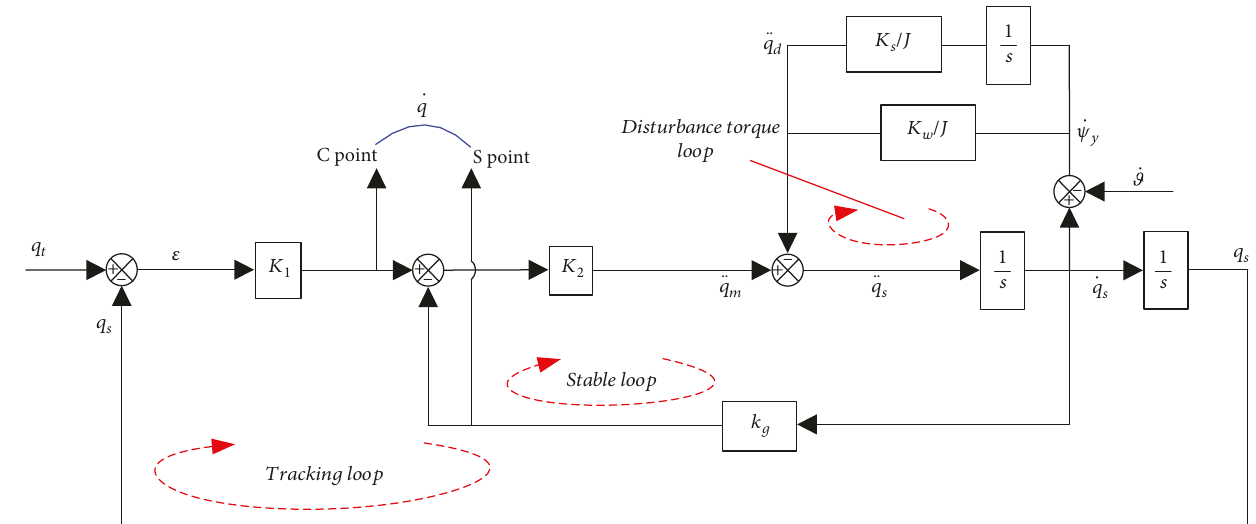
Figure 5: Bode diagrams of the DRR characteristic.